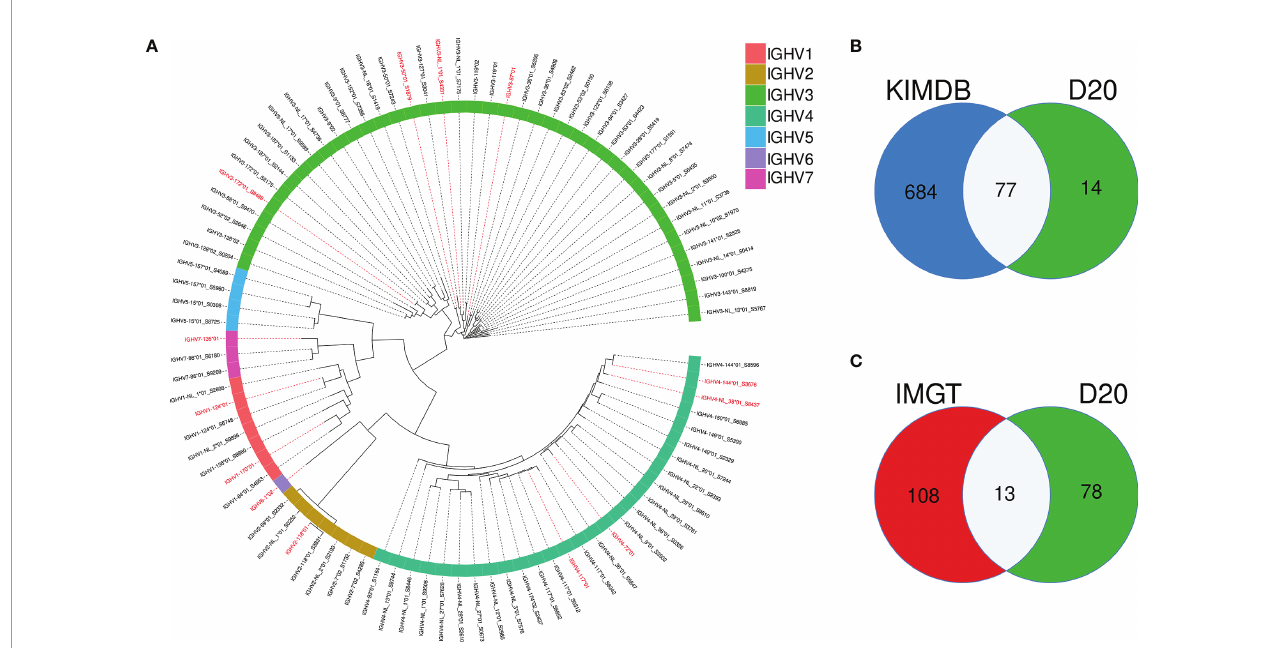
FIGURE 2 | Overlap of IGHV alleles in animal D20 with alleles present in the rhesus macaque IMGT database and KIMDB. (A) An approximate maximum likelihood tree of D20 IGHV alleles with alleles that are identical to IMGT alleles labeled in red. (B) Venn diagram showing the overlap between IGHV alleles present in D20, marked in green, and KIMDB, marked in blue (C) Venn diagram showing the overlap between IGHV alleles present in D20, marked in green, and the IMGT rhesus macaque database marked in